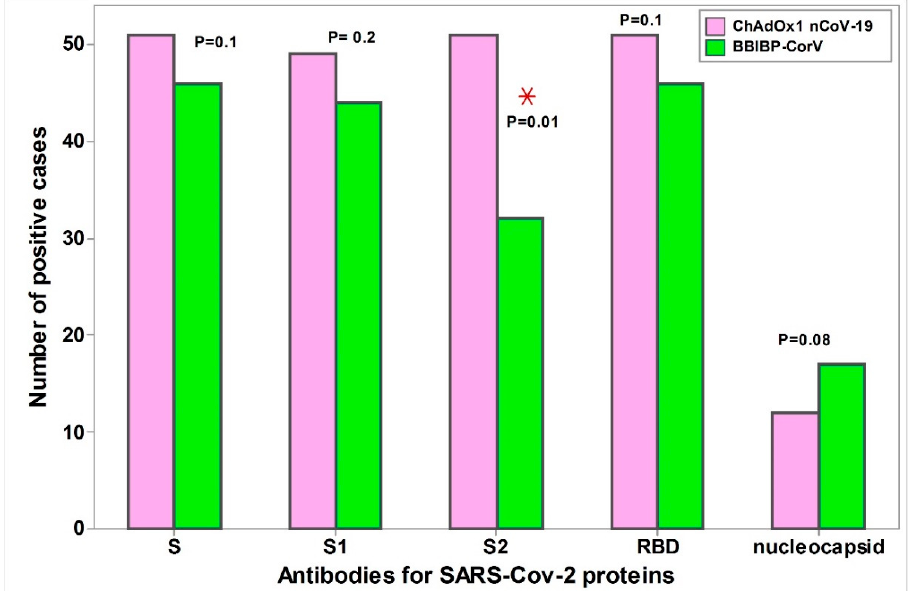
Figure 1. Humoral immune response after the second doses of the ChAdOx1 nCoV-1 and the BBIBPCorV vaccine. * Test of significance: chi-squared test, p < 0.05 was considered significant. Cutoff of MFI for Anti-Spike was 7500, Anti-Spike S1 was 4000, Anti-Spike RBD was 3500, Anti-Spike S2 was 1900, Anti-nucleocapsid was 3500. * Represents the Statistically significant values. Table 2. Humoral immune response after the first dose of the ChAdOx1 nCoV-1 vaccine and the second dose of both vaccines (n = 109).